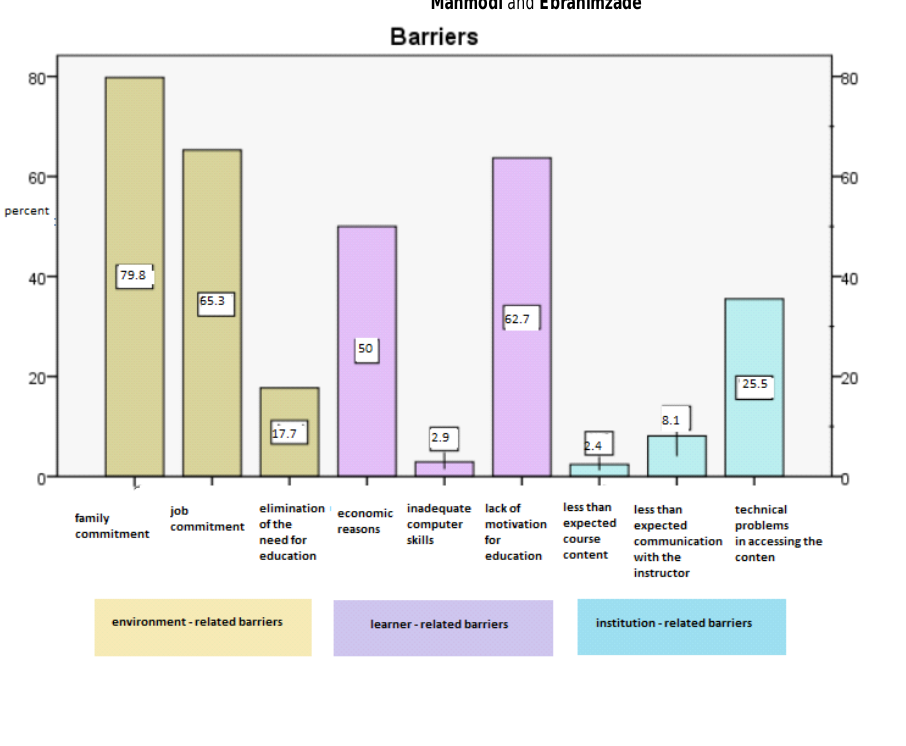
Figure 4. Percentage of non-persistent students’ answers to each of the questions concerning barriers to